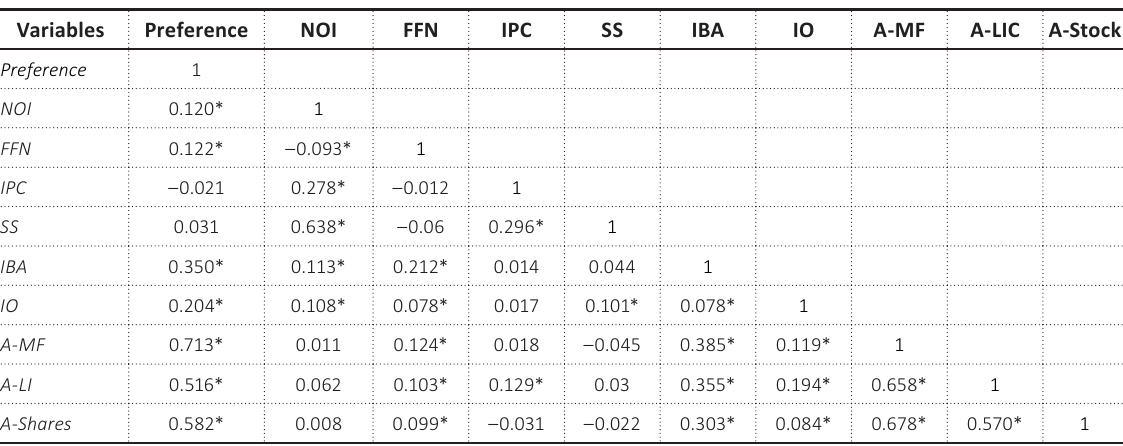
Table 7. Correlation between variables